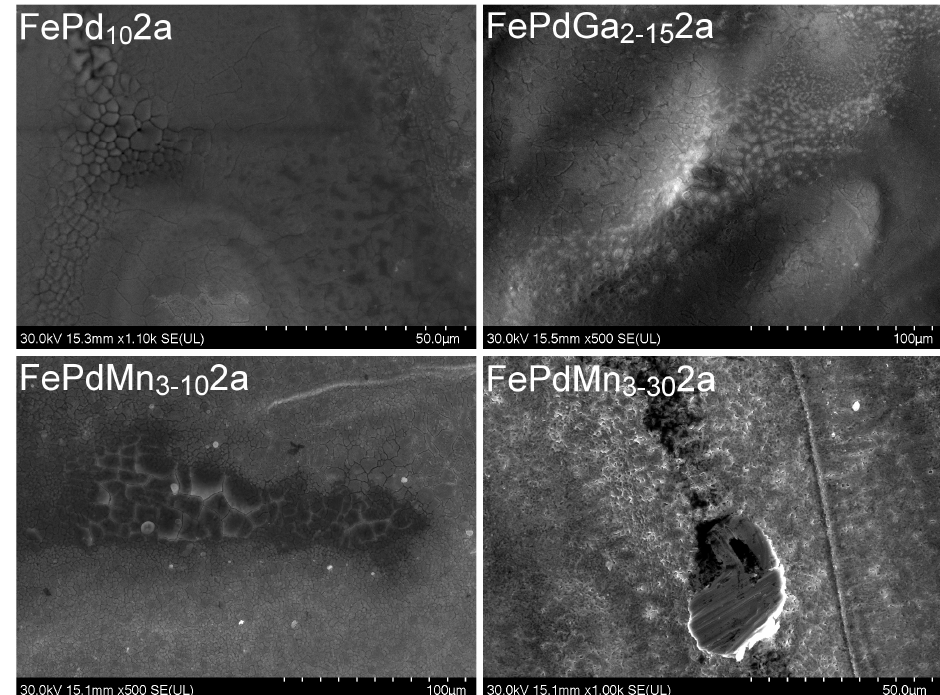
Figure 4. SEM results for FSMA coated with 2a.